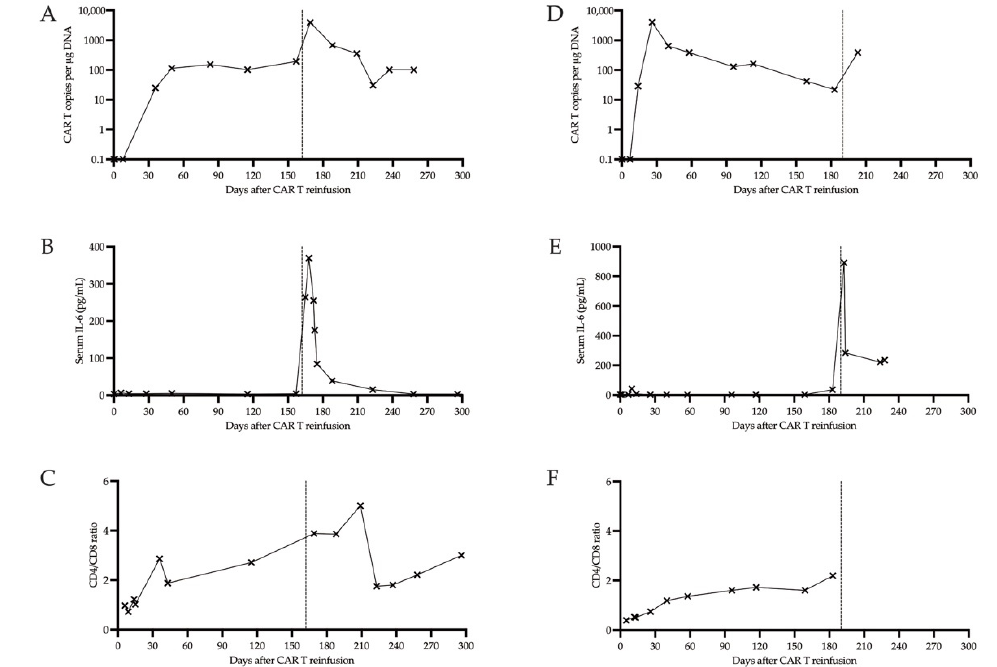
Figure 1. Course of parameters assessed before and after glofitamab initiation, which is indicated by a dashed line. Panels (A–C) show the course of patient #1. We observed a marked increase in CAR T DNA (panel A ), Serum IL-6 (panel B ) and CD4/CD8 ratio (panel C ) after the first administration of glofitamab. Panels (D–F) show the course of patient #2. Again, we observed an increase in CAR T DNA (panel D ) and elevated serum IL-6 levels (panel E ) after the first administration of glofitamab. Unfortunately, due to the patient declining further active treatment, no further flow cytometric assessments were performed (panel F ).